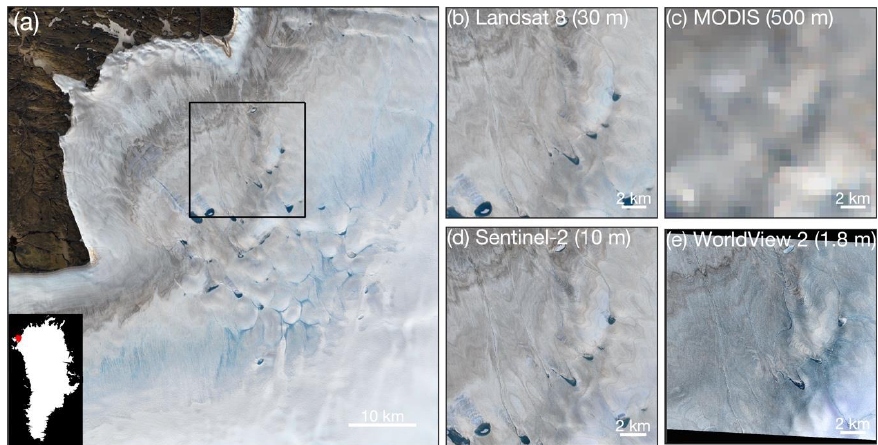
Figure 10. Satellite images of the ablation zone proximal to Inglefield Land in northwest Greenland (78.64 ◦ N, 65.89 ◦ W), showing bands of outcropping dust in bare ablating ice, supraglacial lakes and rivers indicating melting ice, and what appears to be snow, firn, or otherwise non-melting ice that may indicate the approximate location of the summer snowline. ( a ) Landsat-8 Operational Land Imager 30 m resolution image (RGB: bands 4 (red), 3 (green), and 2 (blue)) acquired on 16 July 2016. Elevations in this image range from 600 m a.s.l. at the ice sheet edge to ~1500 m a.s.l.; ( b ) same as (a), but for detail box; ( c ) MODIS/Terra MOD09A1 500 m resolution 8-day composite image (RGB: bands 1 (red), 4 (green), and 3 (blue)) acquired on 27 July – 03 August 2016; ( d ) Sentinel-2 Multispectral Imager 10 m resolution image (RGB: bands 4 (red), 3 (green), and 2 (blue)) acquired on 23 July 2016. ( e ) WorldView-2 image © 2019 DigitalGlobe, Inc. (RGB: bands 5 (red), 3 (green), and 2 (blue)) resampled to 1.8 m resolution (native resolution: 0.5 m) acquired 03 September 2019. Images in (b) – (e) demonstrate the range of spatial resolutions typically used for studying the ablation zone.